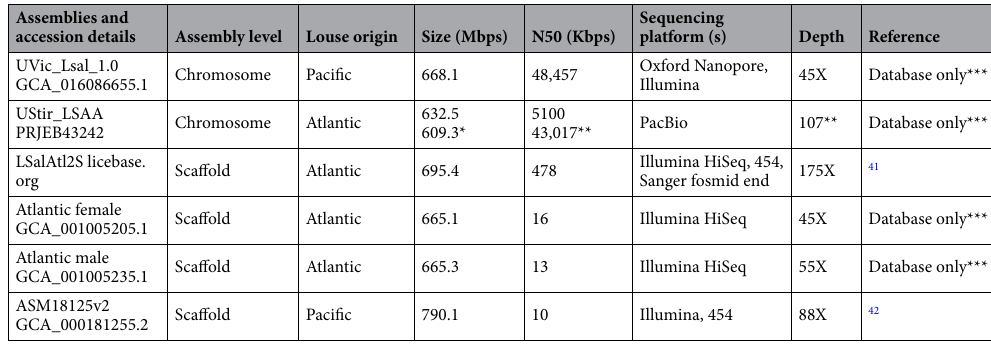
Table 1. Key statistics and sequencing platforms for salmon louse assemblies available March 2021. Depths of sequencing coverage are the values associated with the assemblies and are estimated based on assembly- indicated genome sizes (i.e. ≈700 Mbps). The ASM18125v2 assembly is quite fragmented and the authors indicate that the assembly overestimates the actual size suggested to be around 600 Mbps (https:// www. ncbi. nlm. nih. gov/ biopr oject/ PRJNA 40179). Only LSalAtl2s is extensively assessed and the predicted gene set appears to be quite complete as it contains 92.4% of the expected genes in a BUSCO analysis and maps ≈ 90% of transcriptome reads 48,49 . *The UStir_LSAA assembly comprised 158 sequences in total, 15 of which were identified as chromosomes. The value denoted ‘*’ is the assembly size for these 15 chromosomes. **Calculated based on the 632.5 Mbp assembly size. ***Data available in public repositories were included with permission from the assembly authors in adherence to the Fort Lauderdale agreement 50 .